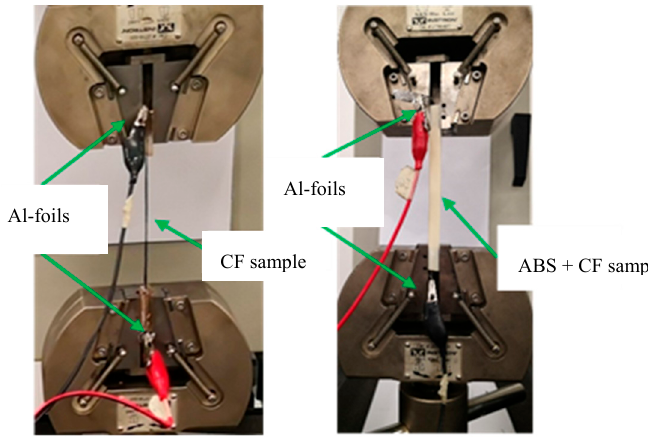
Figure 8. Tensile test setup.